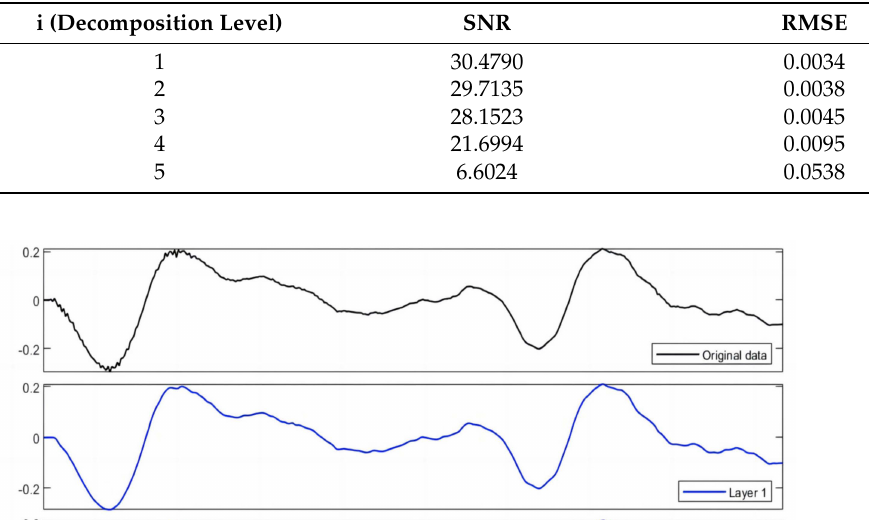
Table 4. Wavelet packet transform different decomposition denoising effect.